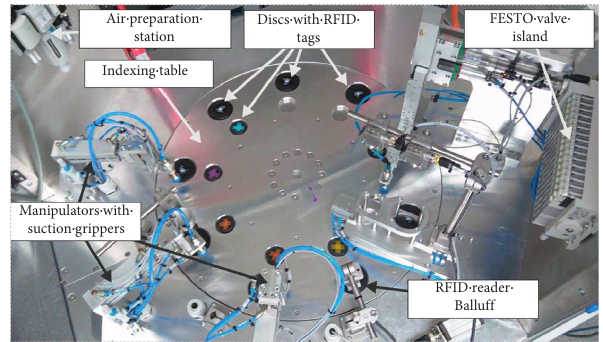
Figure 3: The indexing table with colored